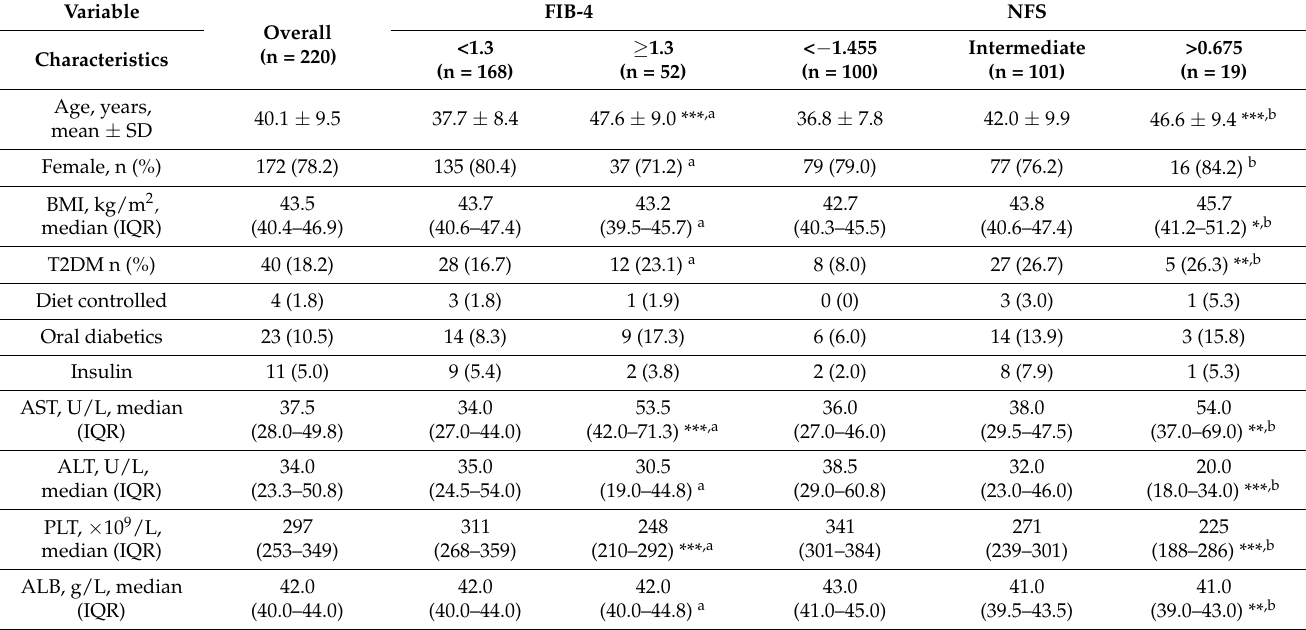
Table 1. Study population prior to Roux-en-Y gastric bypass